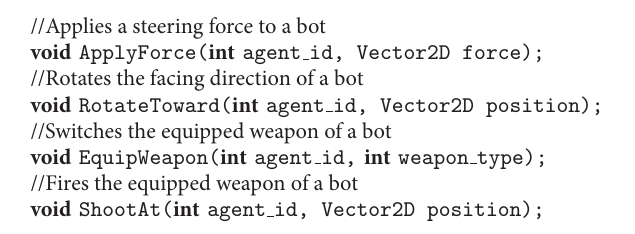
Algorithm 9: Conceptual controls used by the AI in Graven. In order, these are used by the conceptual AI to send commands to apply a steering force to a bot, to rotate a bot toward a certain position, to switch the currently equipped weapon of a bot, and to fire a bot’s weapon at a given position. Together, these conceptual controls are sufficient to replicate the intricate behavior from the original